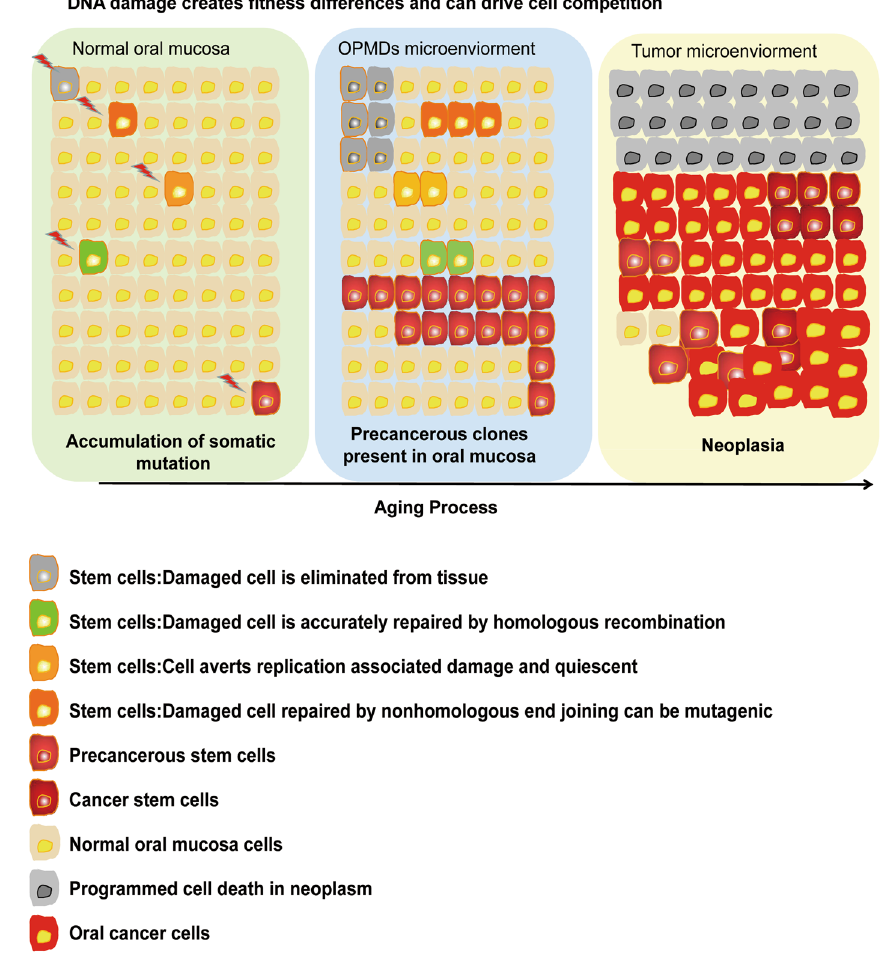
Fig. 1 Mutations accumulate in young stem cells of normal oral mucosa (lawn green). Mosaic patches result from age‑dependent clonal proliferation of mutant stem cells via positive selection or neutral drift.